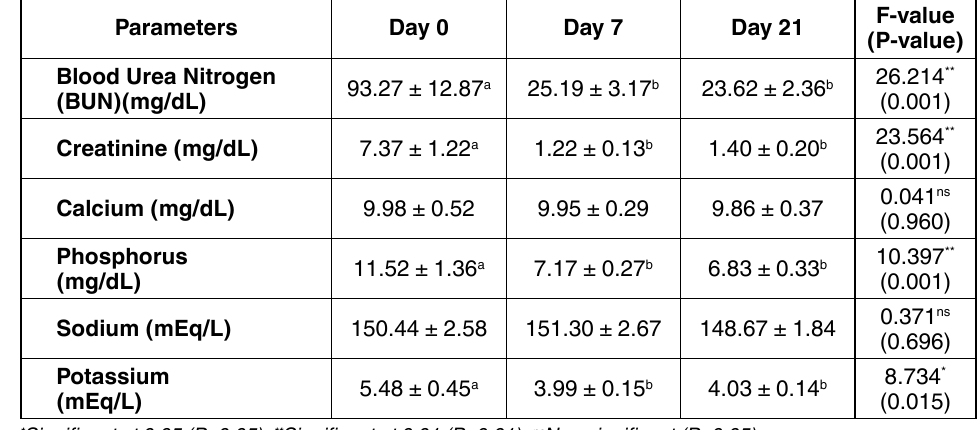
table 4. Observations on serum biochemical parameters (Mean ± SE) in tom cats